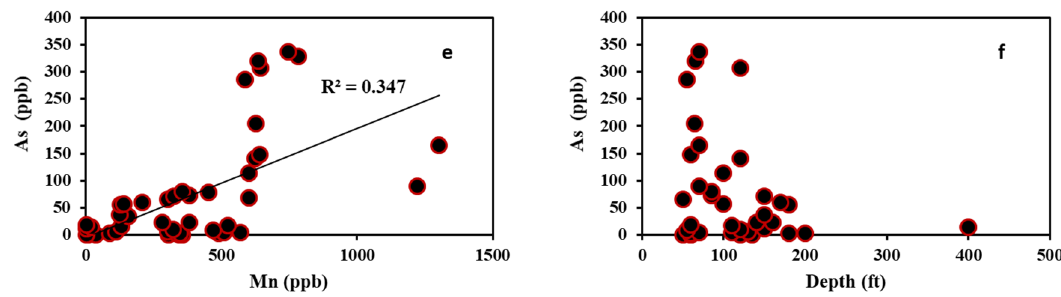
Figure 9. Scatter plot ( a ) As vs. Fe ( b ) As vs. pb ( c ) As vs. Zn ( d ) As vs. Cd ( e ) As vs. Mn ( f ) As vs. depth.